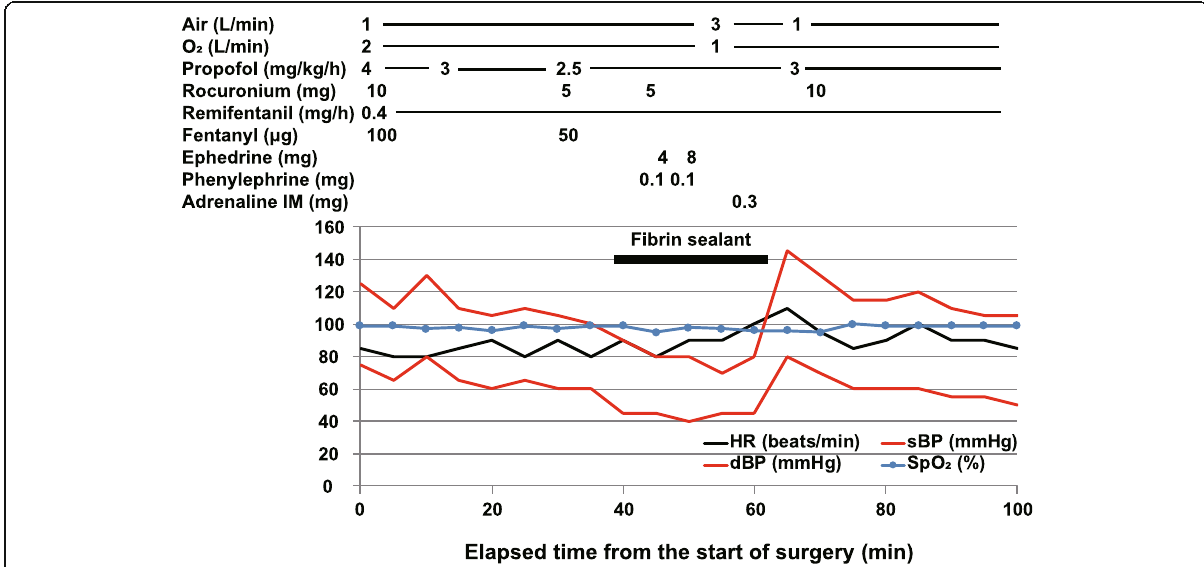
Fig. 1 Drugs used during surgery and changes in vital signs. The horizontal black bar indicates the period of local application of fibrin sealant. IM, intramuscular injection; HR, heart rate; sBP, systolic blood pressure; dBP, diastolic blood pressure; SpO 2 , percutaneous oxygen